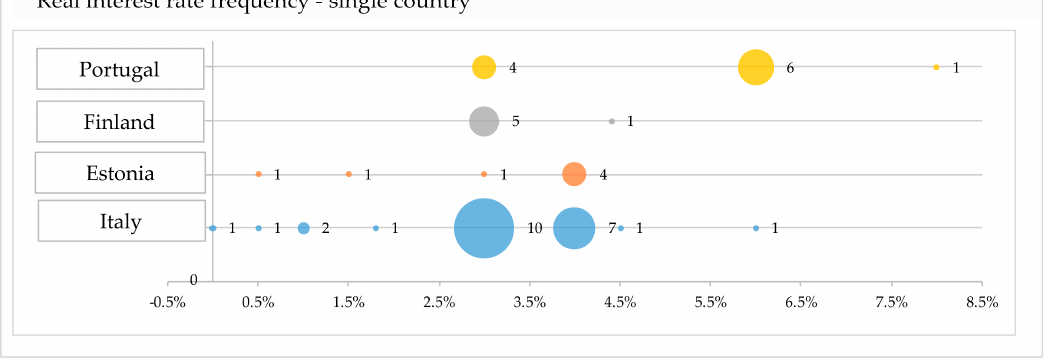
Figure 16. Real interest rate values in the analyzed studies.